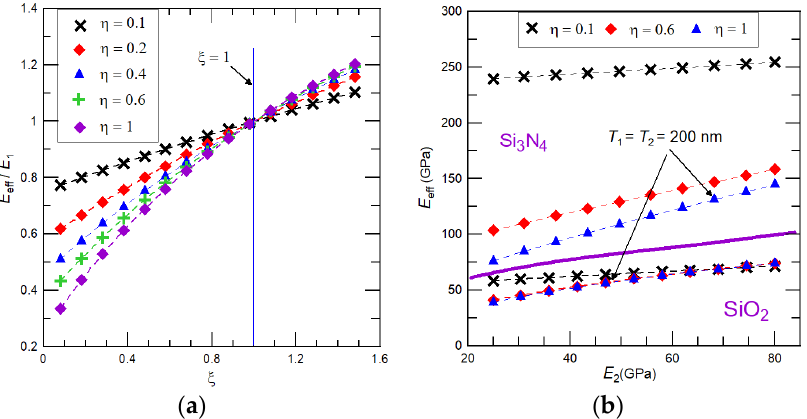
Figure 2. ( a ) Variation of the relative effective Young’s modulus of the cantilever, i.e., E eff / E s , as a function of the temperature-dependent NiTi film Young’s modulus represented through the dimensionless modulus ratio ξ for different thickness ratios η ; and ( b ) the cantilever effective Young’s modulus as a function of the NiTi thin film modulus for two different substrate materials, SiO 2 and Si 3 N 4 .